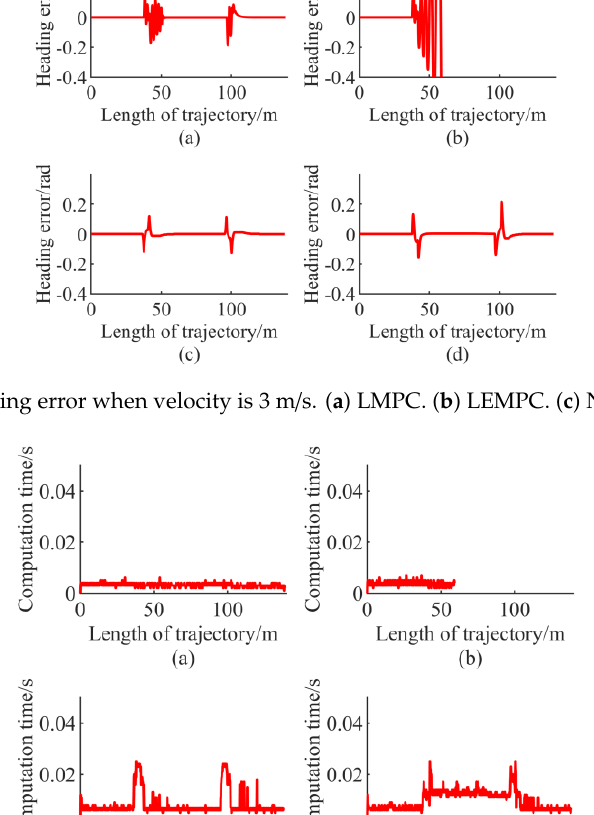
Figure 10. The displacement error when velocity is 3 m/s. ( a ) LMPC. ( b ) LEMPC. ( c ) NMPC. ( d ) NEMPC.